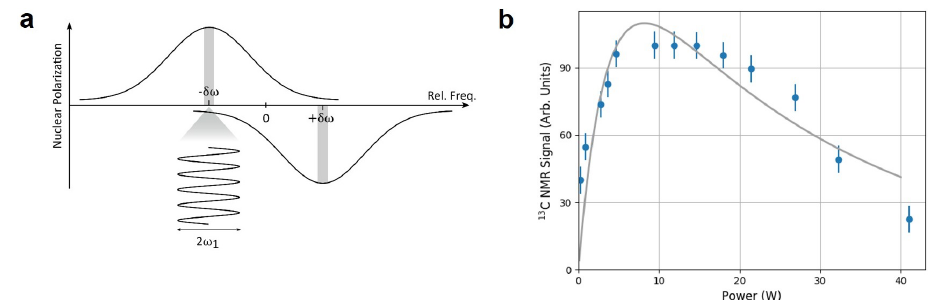
Figure 3. ( a ) The MW excitation, which is on-resonant with the positive polarization, can induce the negative (off-resonant) polarization as well. ( b ) The (normalized) 13 C polarization obtained through optical DNP is measured as a function of MW